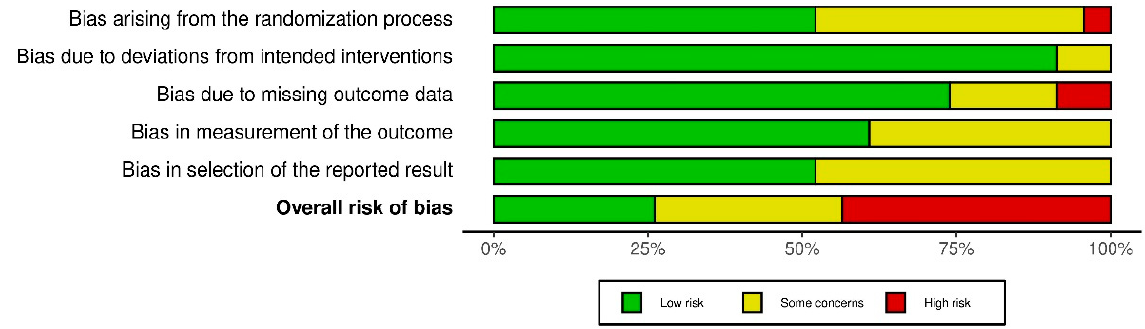
Figure 9. Summary plot of the risk of bias.